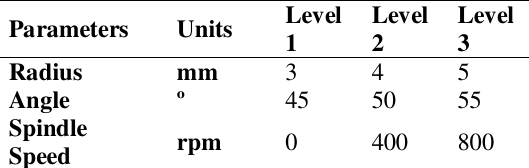
Forming parameters and their levels for the flat with round corner